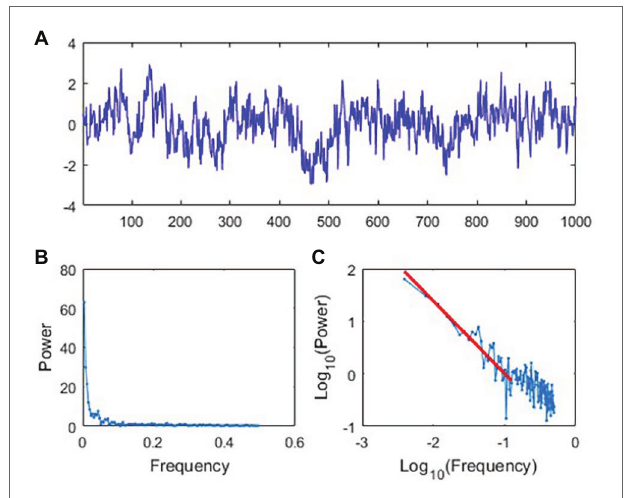
FIGURE 2 | Demonstration of pink noise structure. (A) Simulated time series data representing 1/f β with a pink noise structure. The vertical axis has arbitrary units. (B) Power spectral density for the time series in (A) represented on linear axes. (C) Power spectral density for the time series in (A) represented on base-10 logarithmic axes.